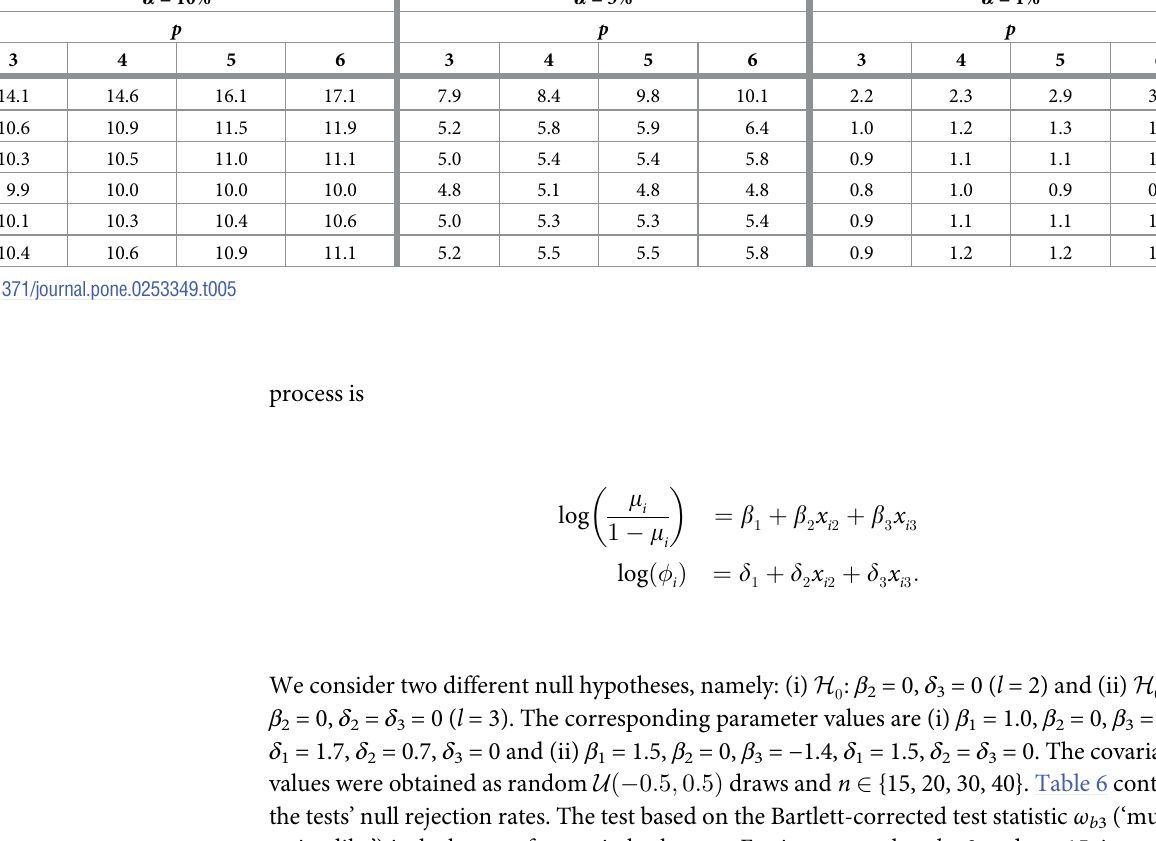
Table 6. Null rejection rates (%), H